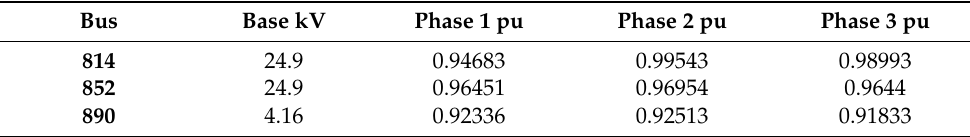
Table 2. Monitored Buses Voltages.